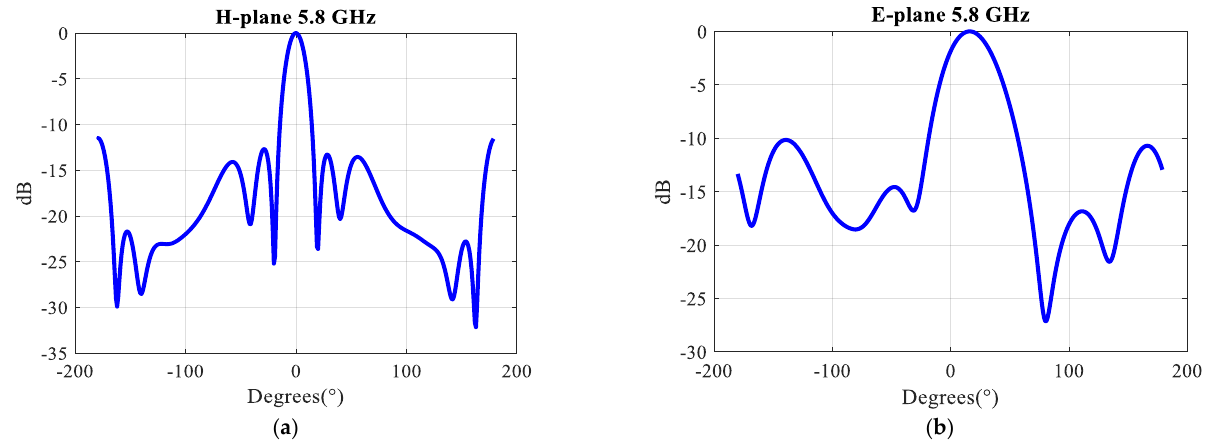
Figure 23. Simulated radiation patterns in ( a ) the H-plane, ( b ) the E-plane of the 2 × 6 array at 5.8 GHz in the case of in-phase excitation of the three MIMO ports.